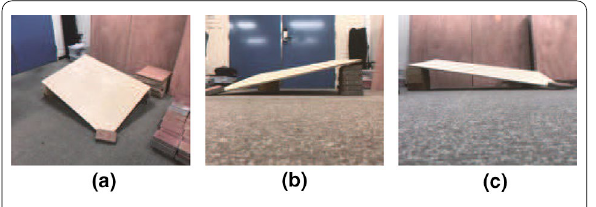
Fig. 11 The Experimental environment. a is the overview of the experimental environment. b and c are the view from x and y direction of the environment respectively